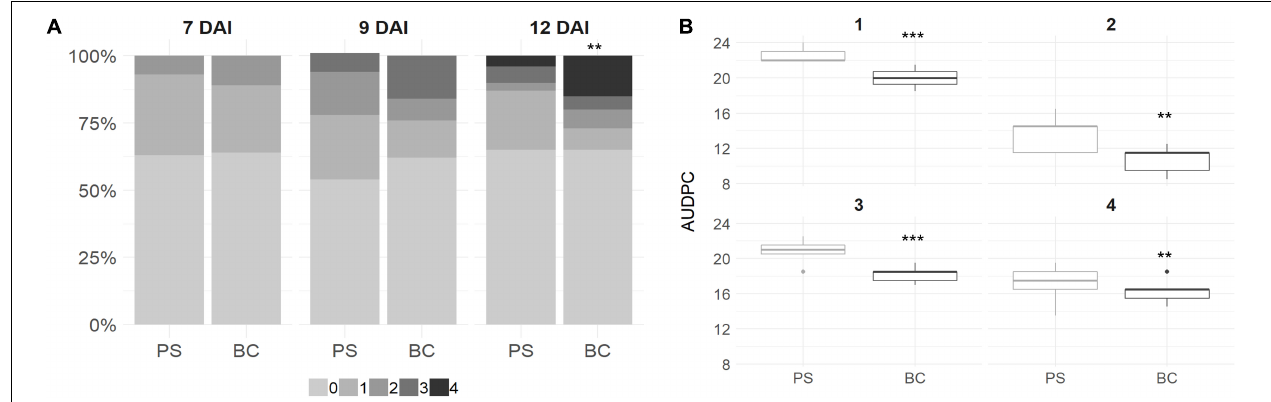
FIGURE 1 | Scoring Botrytis cinerea infection on strawberry plant leaves and fruits. (A) Strawberry plant leaves were inoculated at 8 weeks of plant growth. In total, three fully expanded leaves per plant were inoculated and per condition [peat substrate (PS)] or biochar-amended PS (PS + BC)] and 12 plants were inoculated. The disease was scored with a value of 0 (no infection) to 4 (100% infected leaf) at 7, 9, and 12 DAI. The score abundances over all plants and leaves are visualized. (B) Strawberry fruits ( n = 6 per time point per tray) were inoculated with B. cinerea after picking. Fruits were discarded once infection symptoms were observed, and the AUDPC was calculated based on this measurement and was visualized per treatment. The AUDPC value per tray ( n = 5) is represented in a boxplot. In total, this was repeated four times, indicated by the values 1–4. Statistical significances are indicated with asterisk (** p < 0.01; *** p < 0.001).